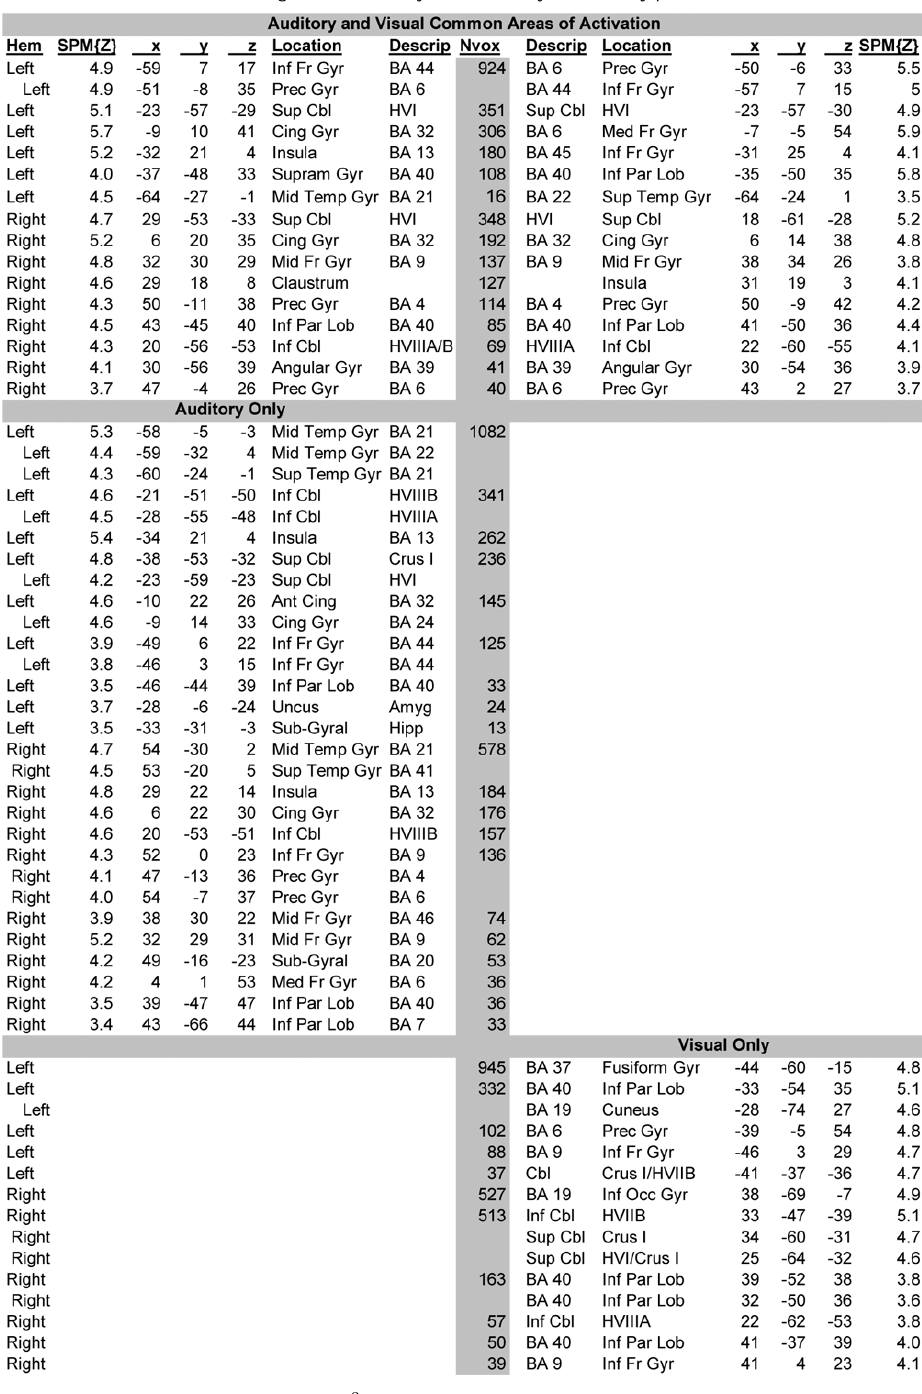
Table 1 Activations for high vs low memory load to aurally and visually presented